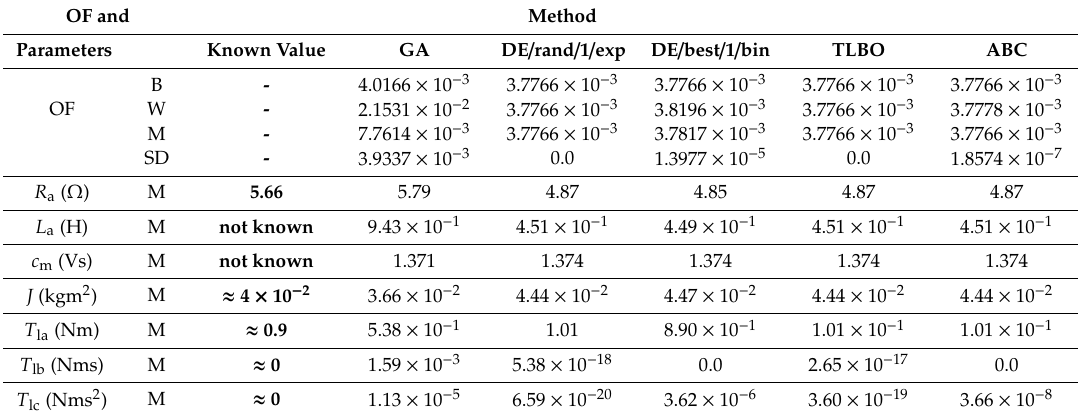
Table 14. OF and Mean value of the calculated parameters for 50 independent runs using RK for MD3.